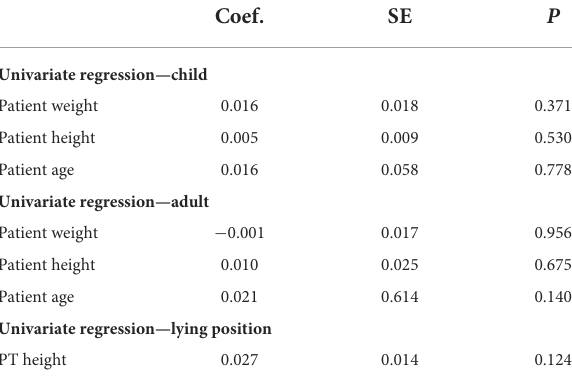
TABLE 4 Coefficient estimates using each physiotherapy variable to predict REBA scores in children and adults.